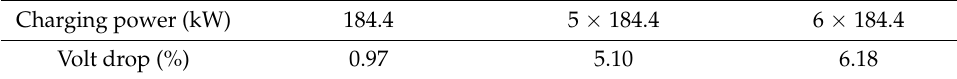
Figure 14. Voltage fluctuation at the point of connection. Table 11. Voltage fluctuation at the DC side.